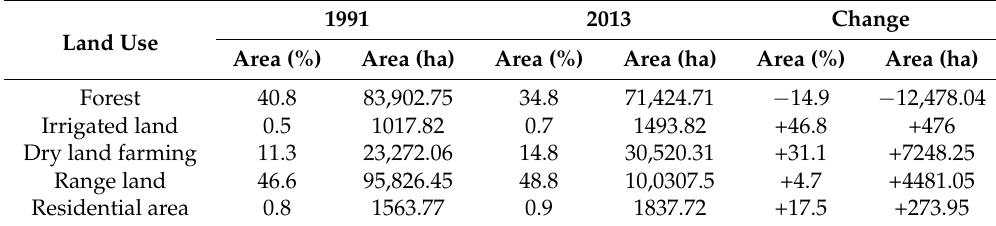
Figure 4. Land use maps for Talar watershed in 1991 and 2013. Table 5. Land use changes between 1991 and